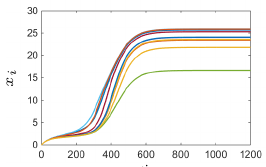
Fig. 6: Time course of the intracellular AHL- concentration of ten cells within one colony with a inhomogeneous distribution of cAMP (i.e. E [ c ] = 0 . 03 , V ar [ c ] = 0 . 00005 ; α l = 0 . 05 )